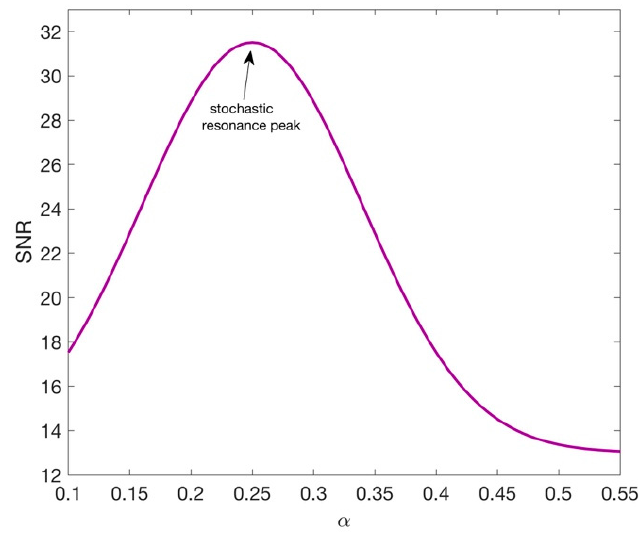
Figure 8. Signal-to-noise ratio (SNR) versus noise level for a = 0.3 as obtained from the data reported in Figure 7.